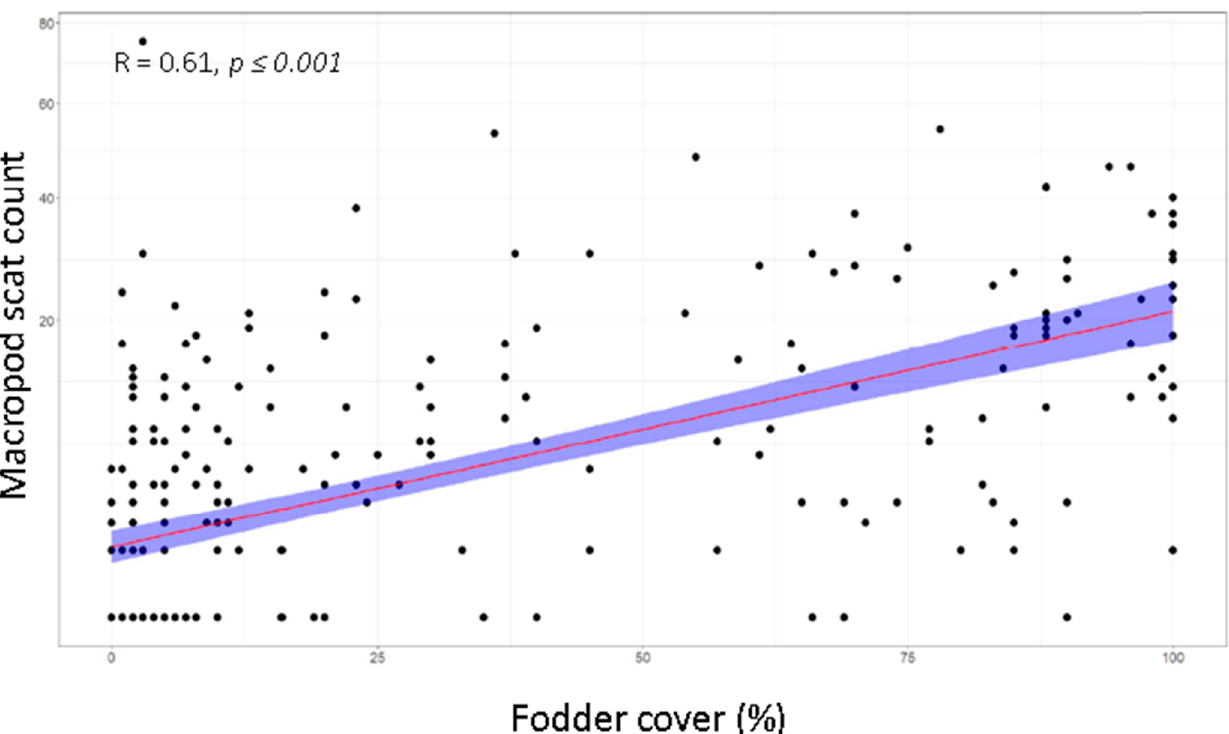
Figure 6. Total scat count (log10) recorded for macropods by percentage fodder cover. Regression line in red, with 95% confidence intervals in blue. Correlation coefficient: R = 0.61, p ≤ 0.001 . Fodder dry weight was a very strong predictor of macropod scats per site in the leg- acy data set (Regression equation: macropod scats = 110.6 + 703.4 Fodder; R 2 = 83.2%) ( df (1,6) ; F = 24.77; p ≤ 0.005), as in our comparison data set using fodder cover (Regression equation: macropod scats = − 0.206 + 0.986 Fodder; R 2 = 98.5%; df (1,119) ; F = 8016.94; p = <0.001). Fodder dry weight was estimated from quadrat ground cover and vegetation height as (t ha − 1 ) [5].